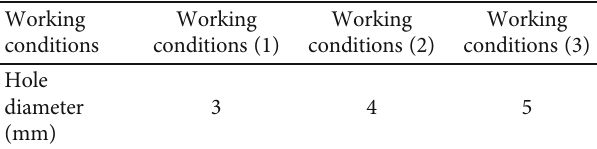
Table 1: The pull on the ribbon under di ff erent speeds.